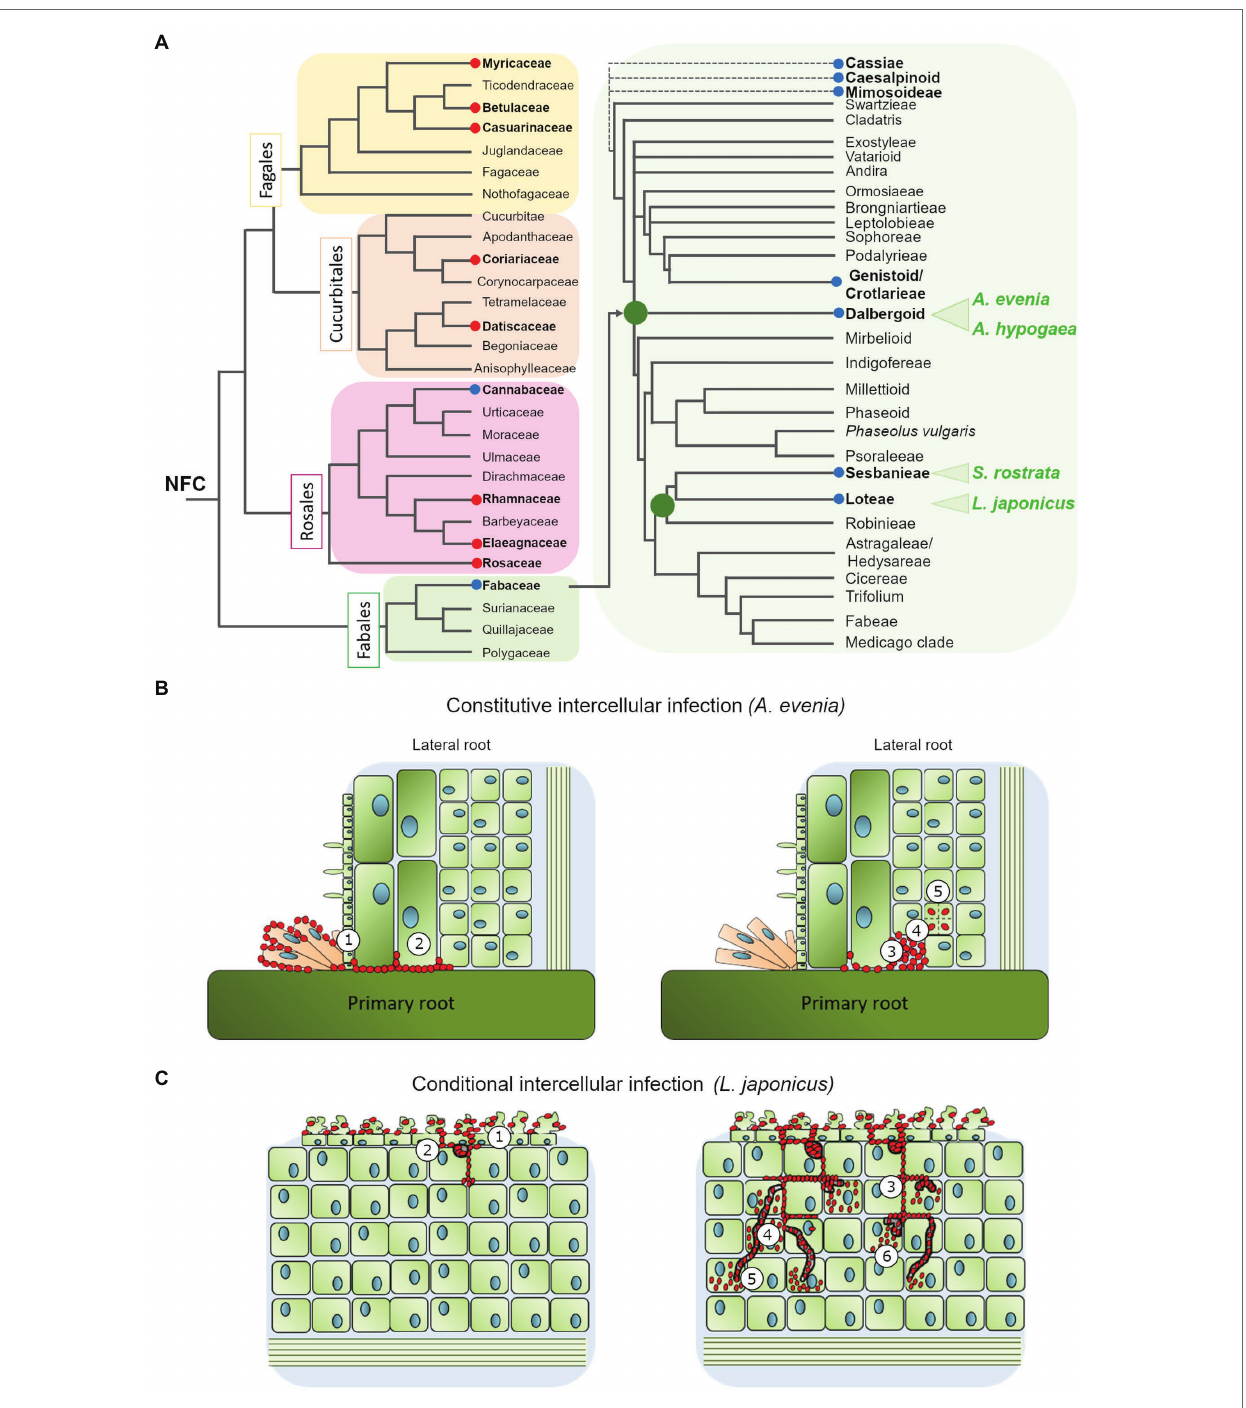
FIGURE 1 | (A) Phylogenetic relationship of the nitrogen-fixing clade (based on Sun et al., 2016; Shen and Bisseling, 2020) with special emphasis in the Fabaceae family (modified from Sprent et al., 2017). The red and blue circles highlight the genera where intercellular colonization by Frankia or Rhizobia occurs, respectively. The four species discussed in this review are marked in green (B) . Intercellular infection mechanism in Aeschynomene evenia : the bradyrhizobium ORS278 intensively colonizes the axillary root hairs at the lateral root base and progresses between cells (1) to reach the cortex (2) where they could induce cell-collapse (3), before bacteria are finally internalized (4) and induce cell division (5). (C) Intercellular infection mechanism in Lotus japonicus : IRBG74 induce massive root hair curling and twisting, followed by intercellular infection of the root epidermis (1). In the cortical cells, IRBG74 is accumulated in infection pockets (2) and from these structures migrates to the nodule cells intercellularly (3) or through transcellular infection threads (4). The bacteria are released into the nodule cells from transcellular infection threads (5) or intercellular infection peg structures